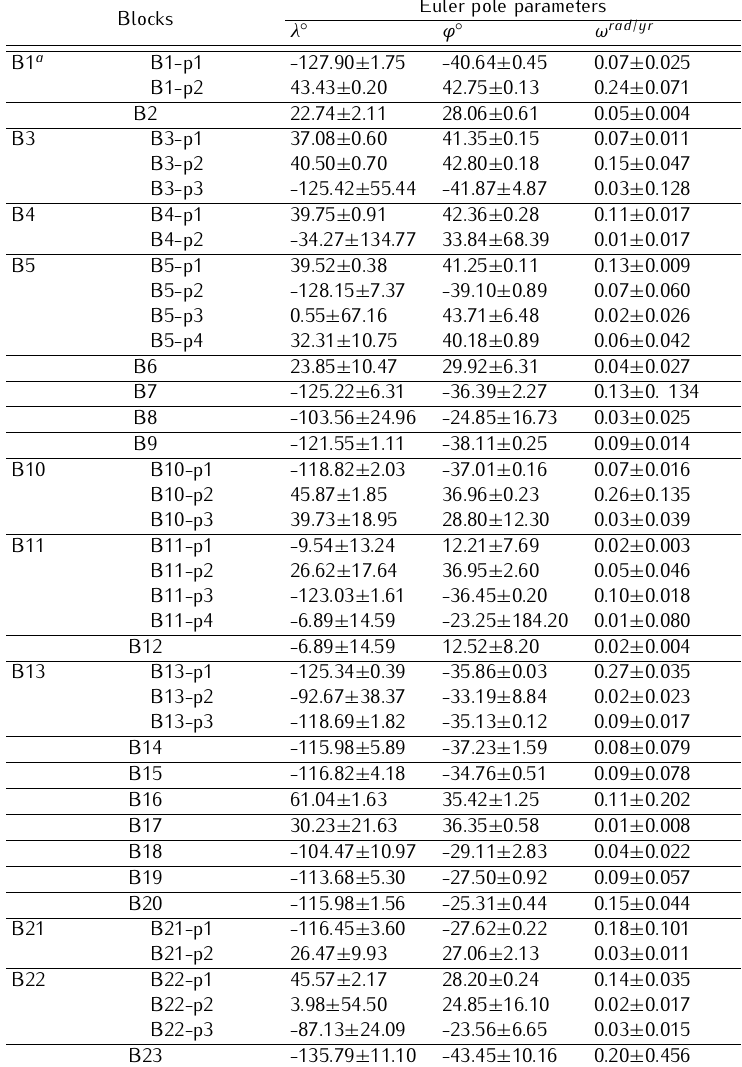
Table 12. Estimated Euler poles for the new pattern of Iranian micro-plates. The positive rotation directions around the poles are clockwise.